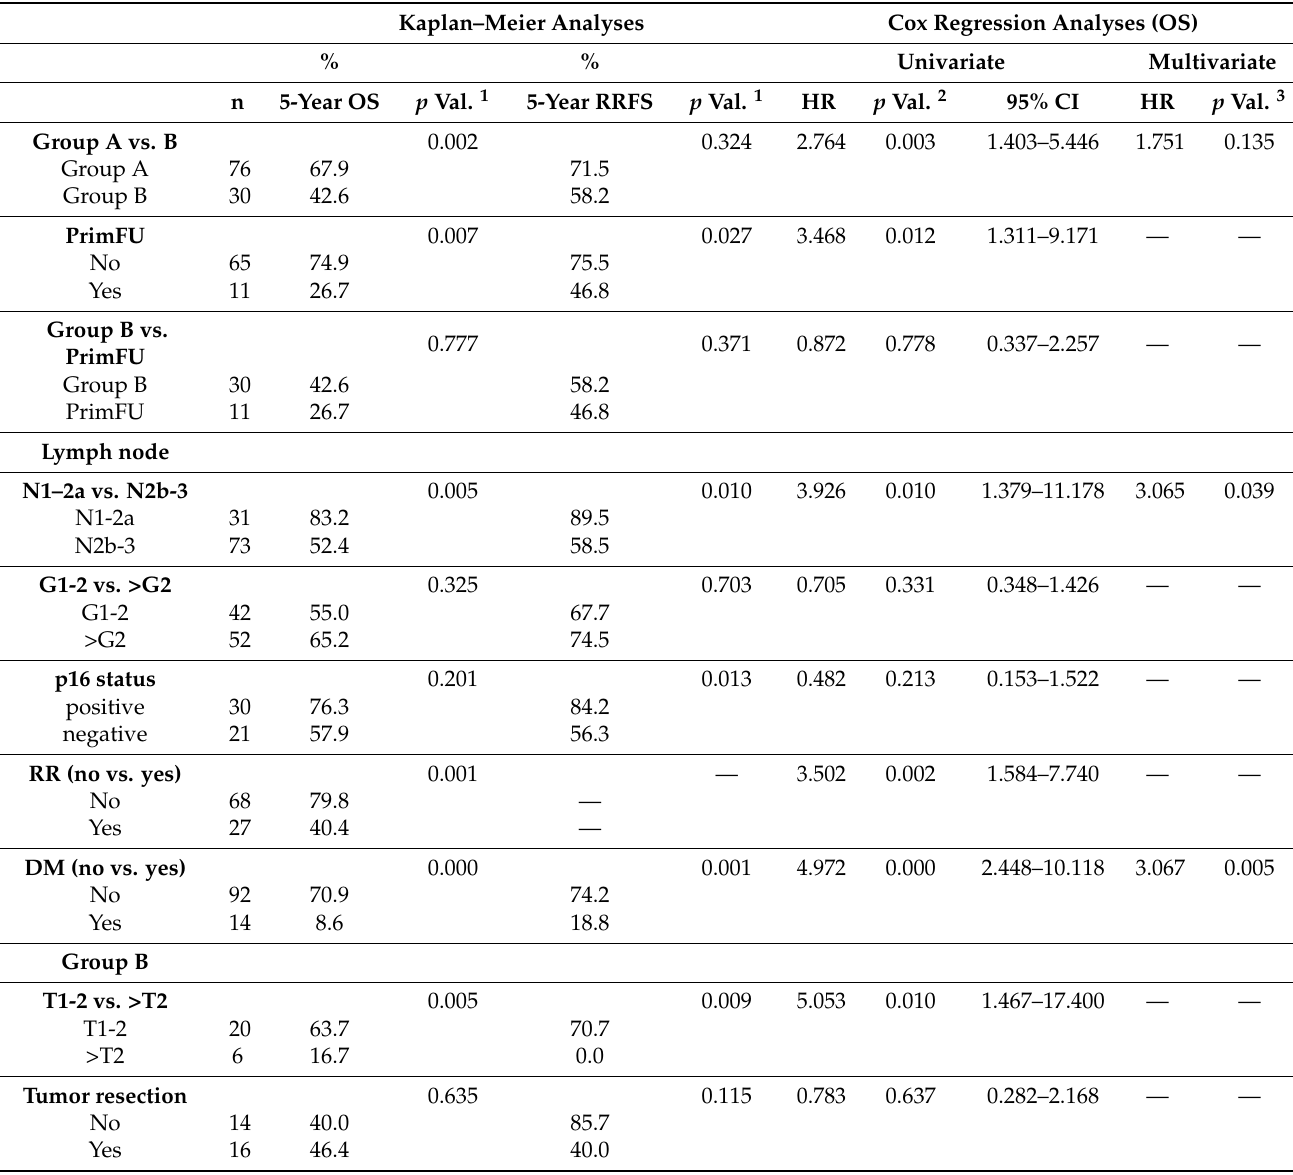
Table 5. Kaplan–Meier and Cox regression analyses in investigated